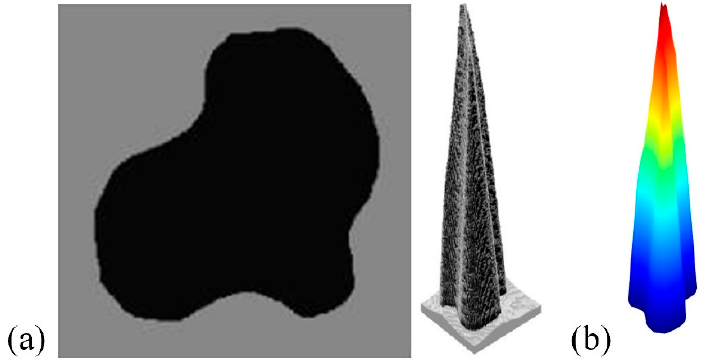
Figure 8. Calculation results for the irregular fiber cross-section: ( a ) Concave complex-fiber cross section and calculation result by Brownian motion simulation method (reprinted/adapted with permission from Elsevier, 2009 [43]); ( b ) the result in this study.